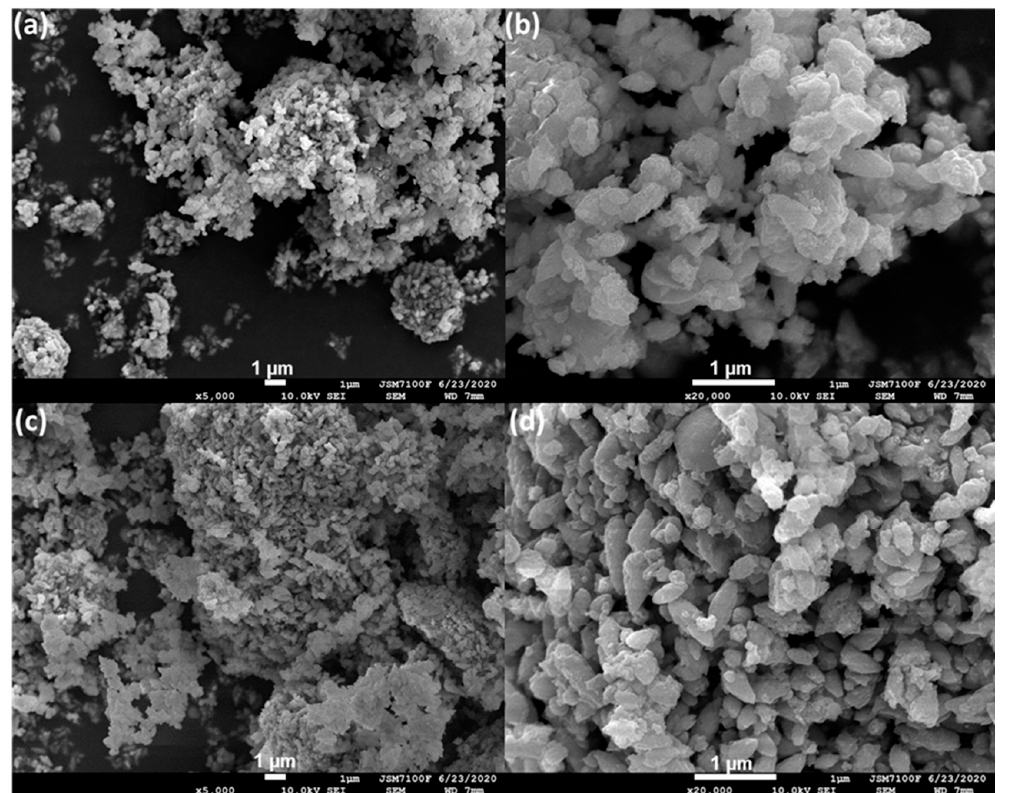
Figure 3. Representative scanning electron microscopic (SEM) images of the samples, ( a ) ( b ) Zn4La—20,000 × , ( c ) Zn4La400—5000 × and ( d ) Zn4La400—20,000 × Zn4La—5000×, ( b ) Zn4La—20000×, ( c ) Zn4La400—5000× and ( d ) Zn4La400—20,000×.